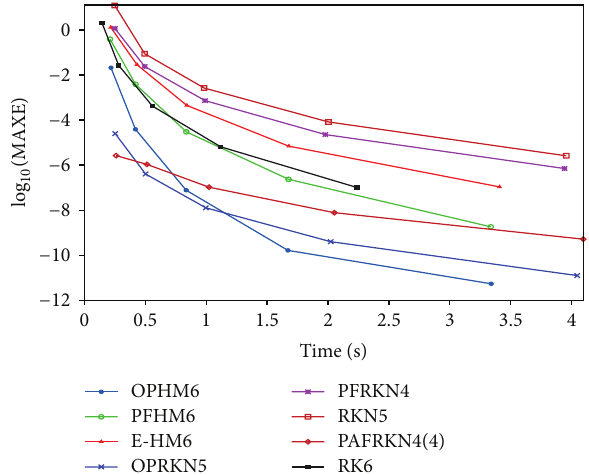
1.41.210.80.60.40.20